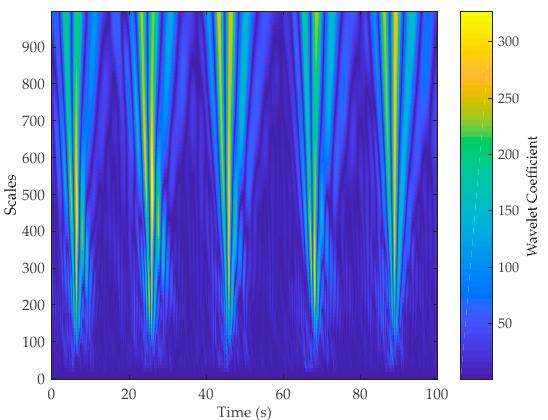
Figure 3. Wavelet coefficient of Channel State Information (CSI) when people move.